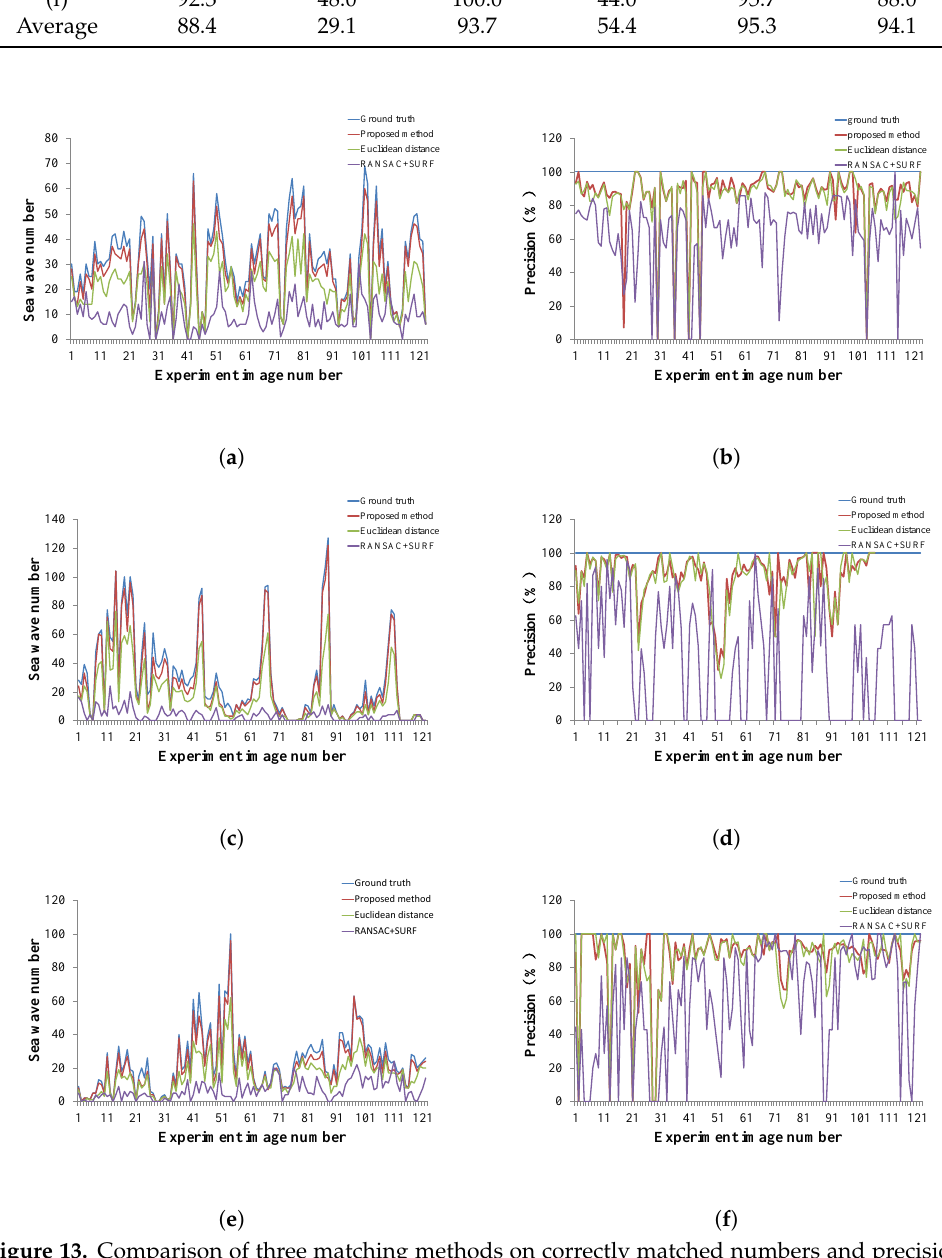
Figure 13. Comparison of three matching methods on correctly matched numbers and precision: ( a , b ) 29 February–6 March 2016 (14–20 km), ( c , d ) 8–15 March 2017 (4–10 km) and ( e , f ) 18–23 August 2018 (8–14